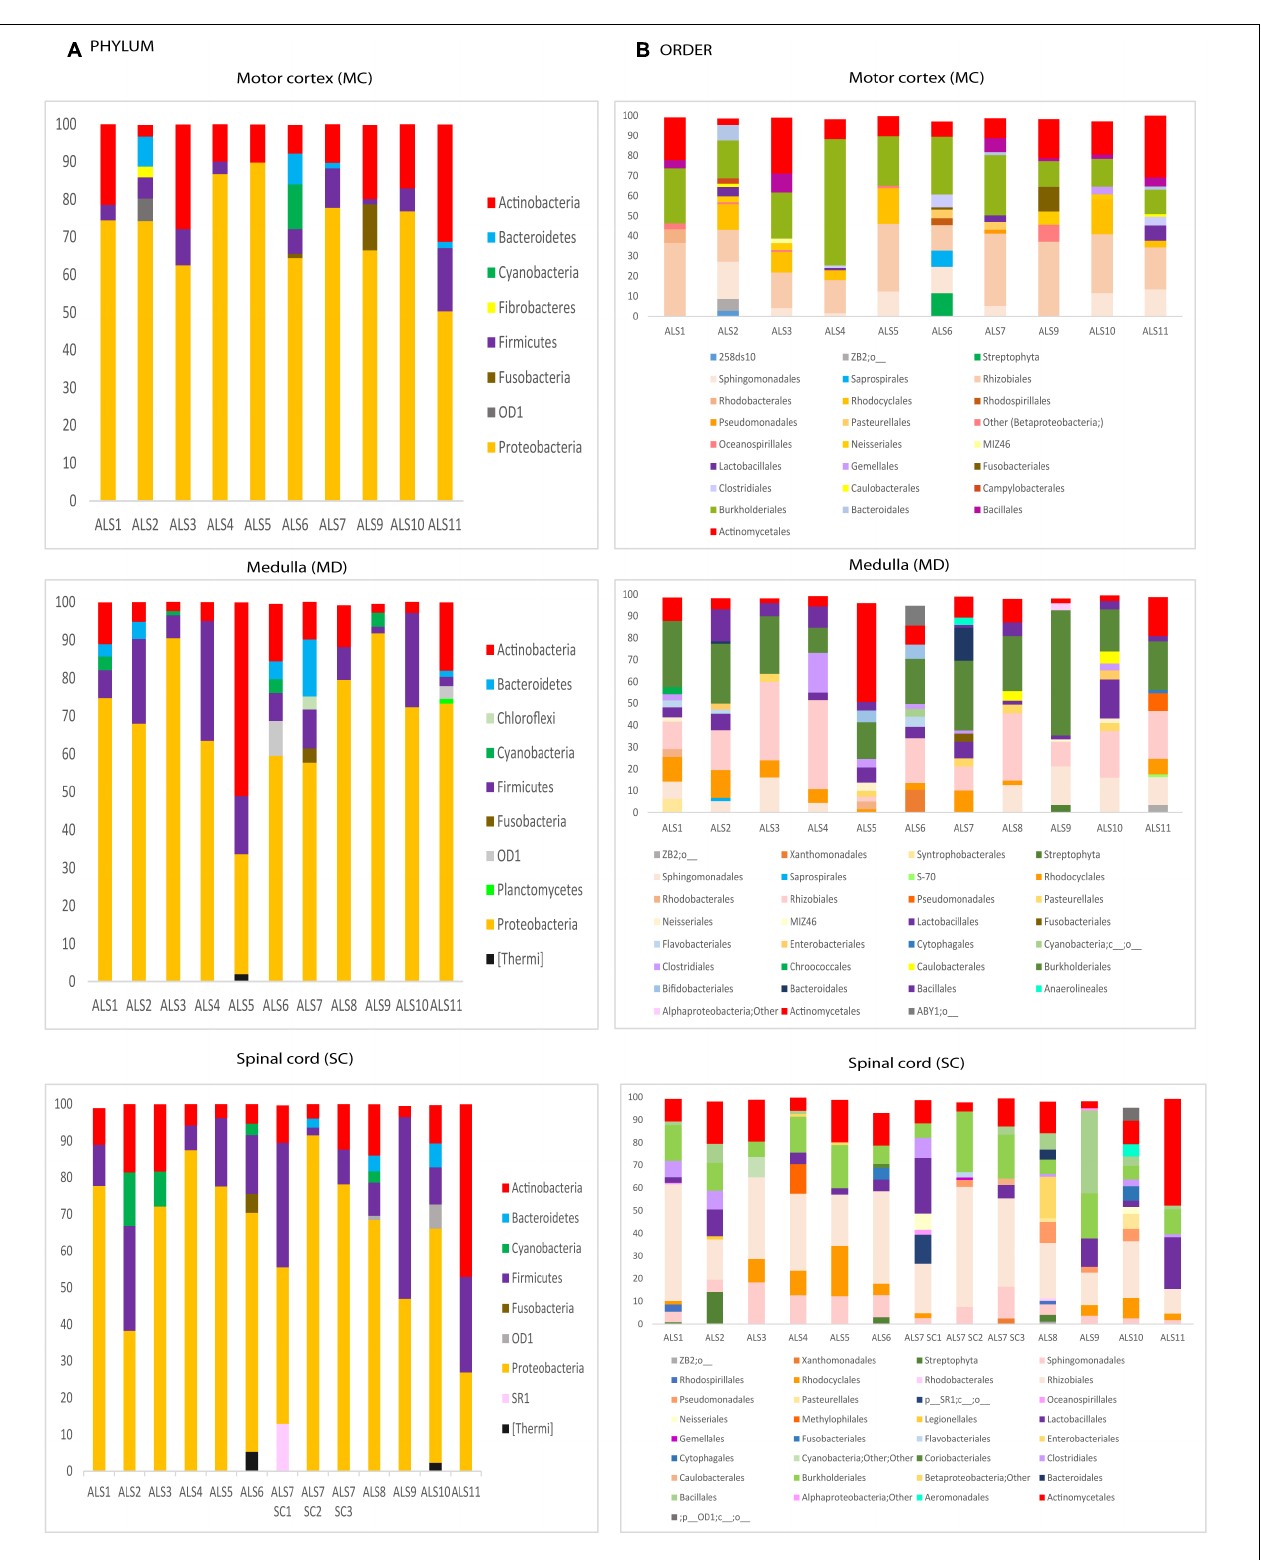
FIGURE 2 | Distribution of bacteria phyla and orders obtained by NGS of DNA from eleven ALS patients. Computational analyses of the sequences obtained on the Illumina platform using Qiime classified the data into bacteria phyla and orders. (A) Panels show the results of bacteria phyla obtained from three CNS regions. (B) Panels show the results of bacteria orders obtained from three CNS regions. SC1, SC2 and SC3, three samples from different regions of the spinal cord.